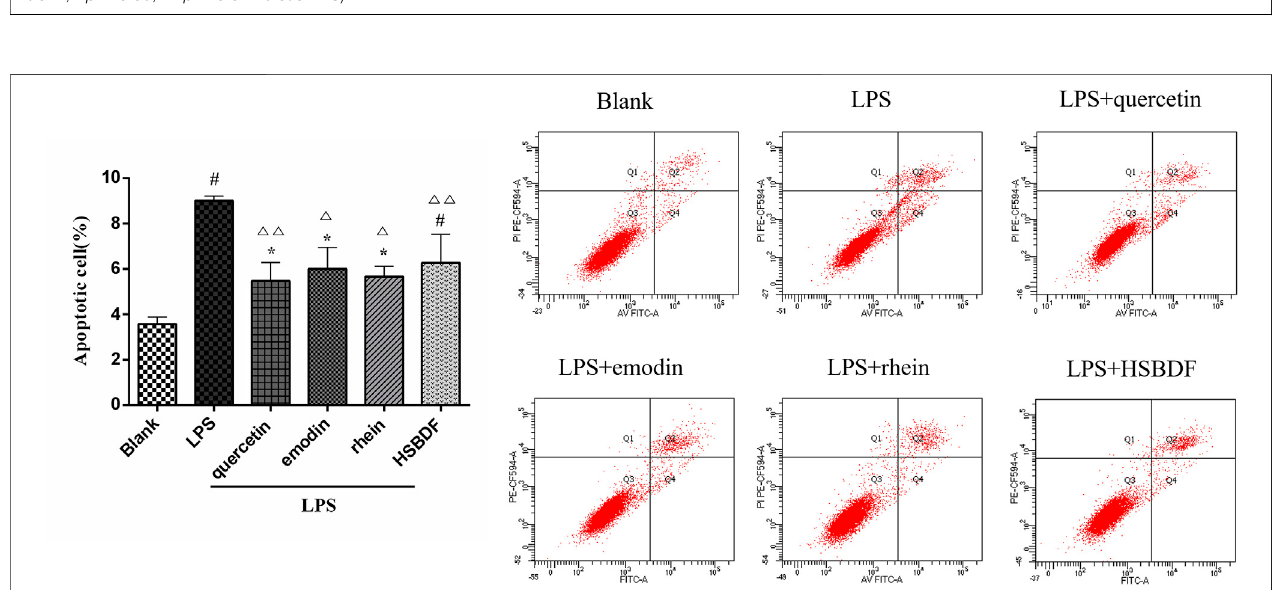
FIGURE6|(A) Effects ofHSBDF and active compound treatmenton theexpression levels ofin fl ammatory cytokine (IL-6 and TNF- α ) inLPS-stimulated A549 cells bytheELISAtest. (B) EffectsofHSBDFand activecompound treatment onoxidativestress(MDAand T-SOD) inLPS-stimulated A549cells(* p < 0.05, # p < 0.01versus blank; △ p < 0.05, △△ p < 0.01 versus LPS).